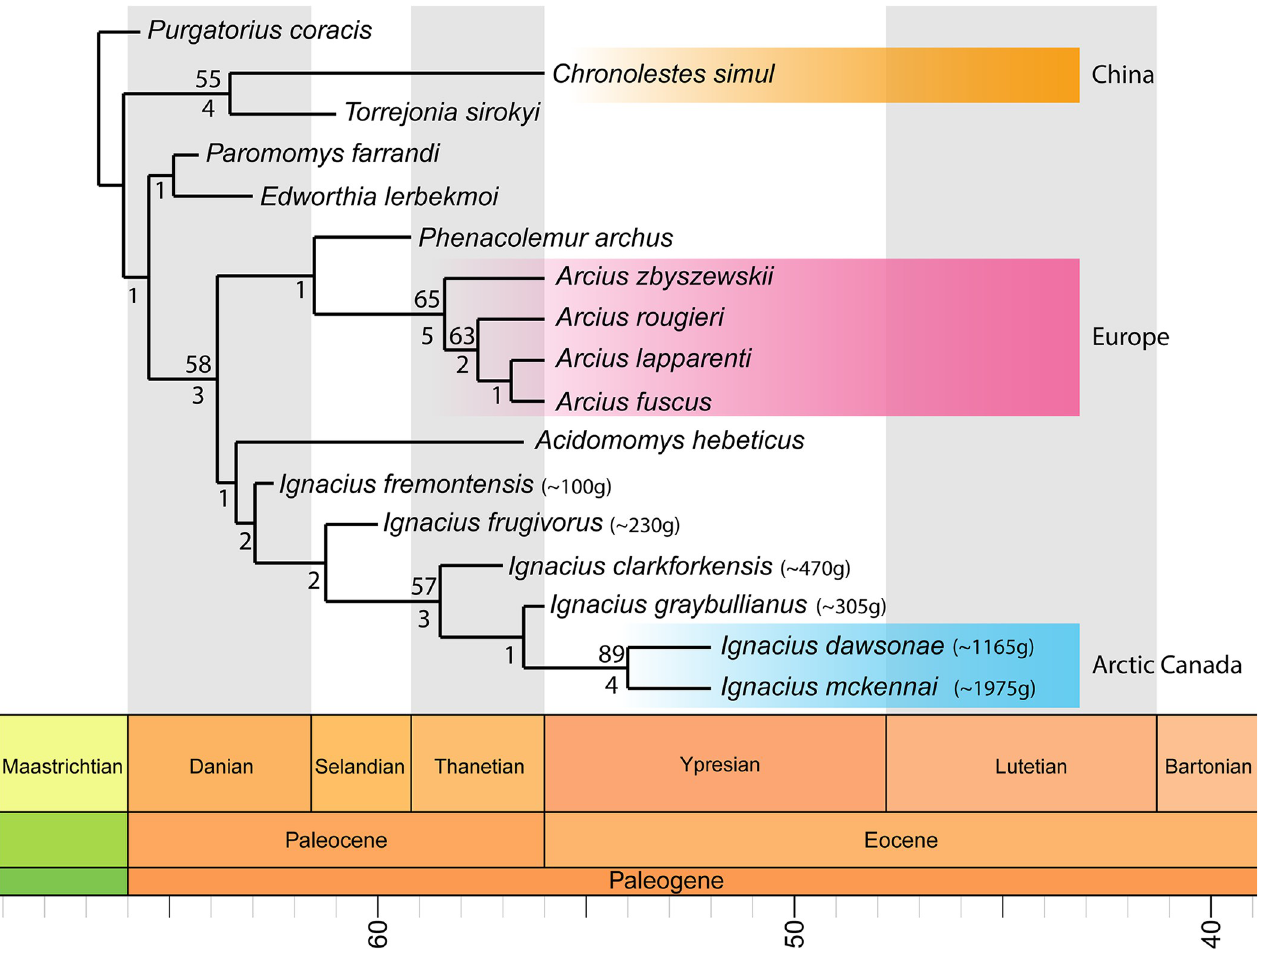
Fig 5. Results of maximum parsimony phylogenetic analysis depicted as a time-scaled phylogeny. Our analysis reconstructs the two new species of Arctic paromomyids as sister taxa that are deeply nested within the Ignacius clade. Heuristic searches yielded a single most parsimonious tree with 183 steps. Bootstrap support was calculated using 1000 replicates with replacement; absolute frequencies > 50% are displayed above nodes. Bremer support values are displayed below nodes. Taxa not in color-coded boxes are geographically restricted to mid-latitudes of North America. Body size estimates for species of Ignacius based on M 1 measurements follow Gingerich et al. [57]. Time-scaled phylogeny was generated using the R package strap “Stratigraphic Tree Analysis for Palaeontology” (see Materials and Methods). Note that estimated divergence dates are a product of the branch-scaling algorithm and do not accurately reflect documented biostratigraphic